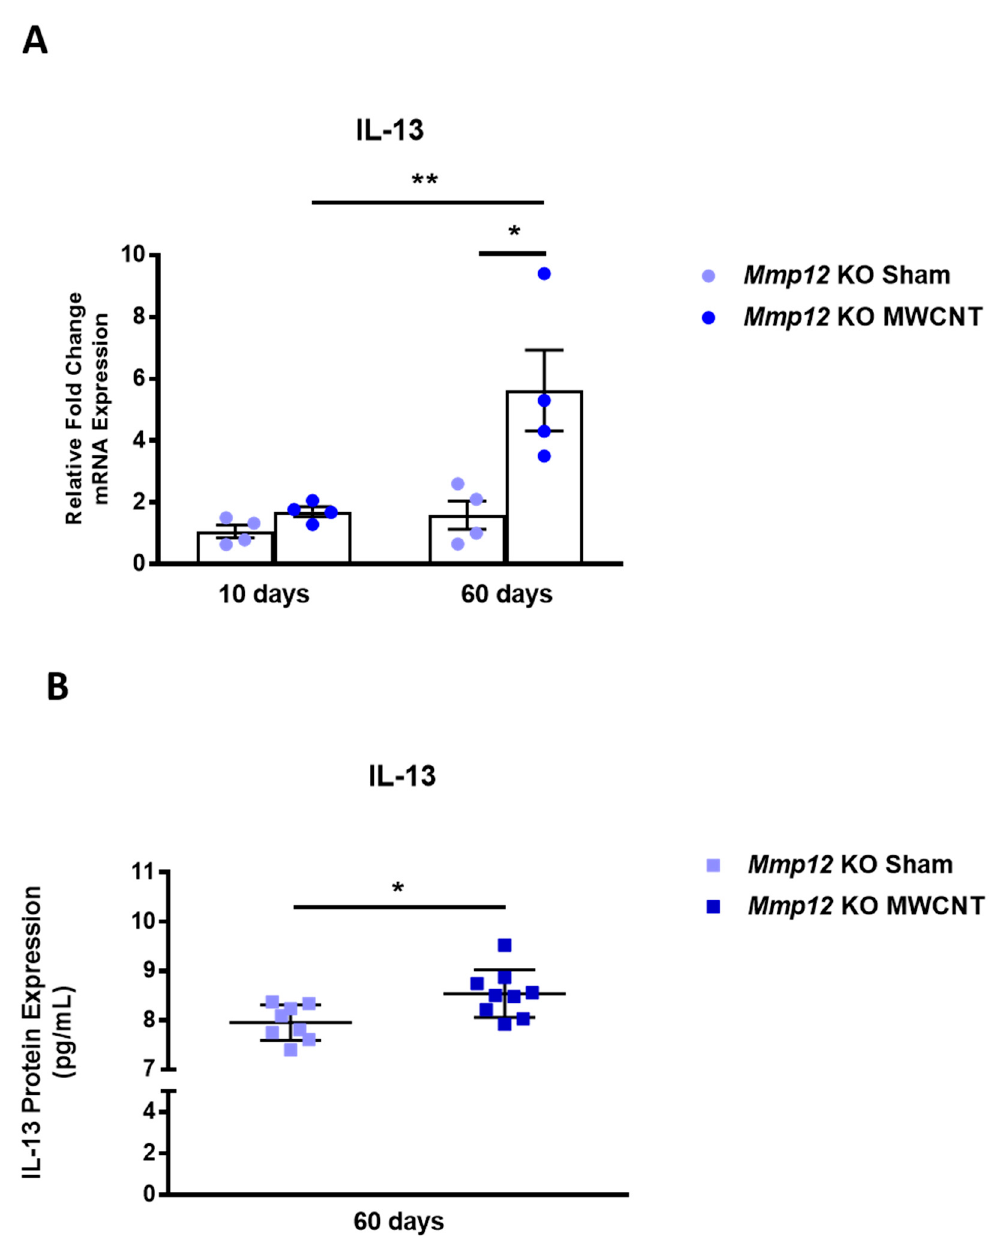
Figure 4. IL-13 gene and protein expression are increased in 60-day BAL cells from MWCNT-instilled Mmp12 KO mice. ( A ) IL-13 gene expression was increased at 60 days, but no change was observed at 10 days. ( B ) IL-13 BALF protein levels were elevated in MWCNT-instilled Mmp12 KO mice at 60 days relative to sham ( * p ≤ 0.05; ** p ≤ 0.01; n = 8/group). At 10 days, IL-13 protein levels were not detectable (data not shown).